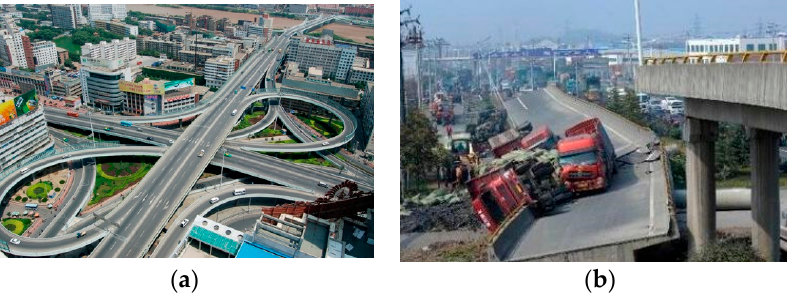
Figure 1. Perspective view and collapse of irregularly-shaped bridges. ( a ) Xiao Xihu overpass in Lanzhou; ( b ) collapsed overpass in Zhejiang [3].